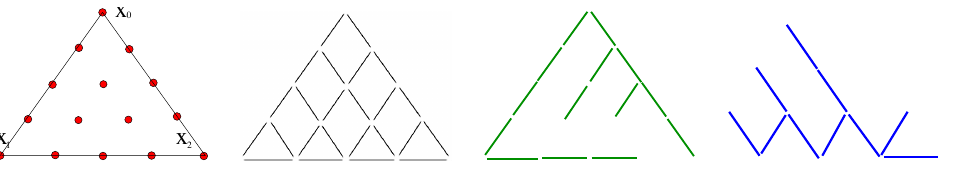
Figure 1. For r + 1 = 4, in a mesh triangle t = [ x 0 , x 1 , x 2 ] , from left to right, are drawn, respectively, the small nodes of the principal lattice, the active small edges of the graph G associated with the small-edge-to-small-node incidence matrix G , a spanning tree in G and its